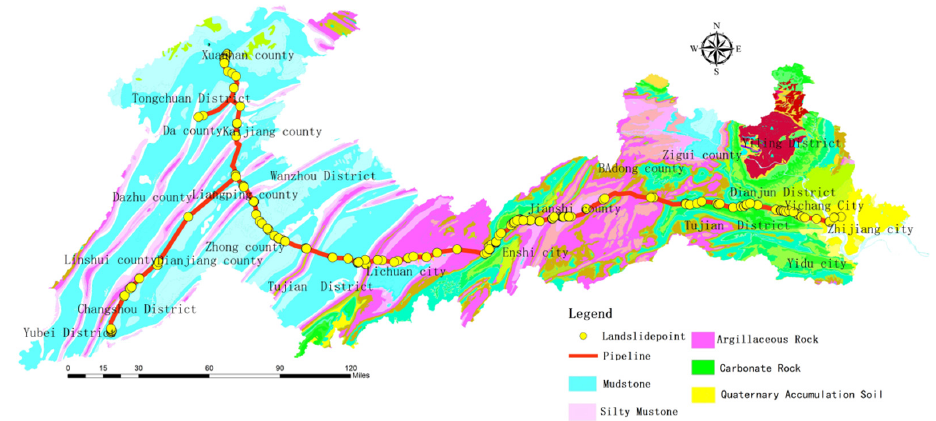
Figure 3. Hazard point and lithology map.